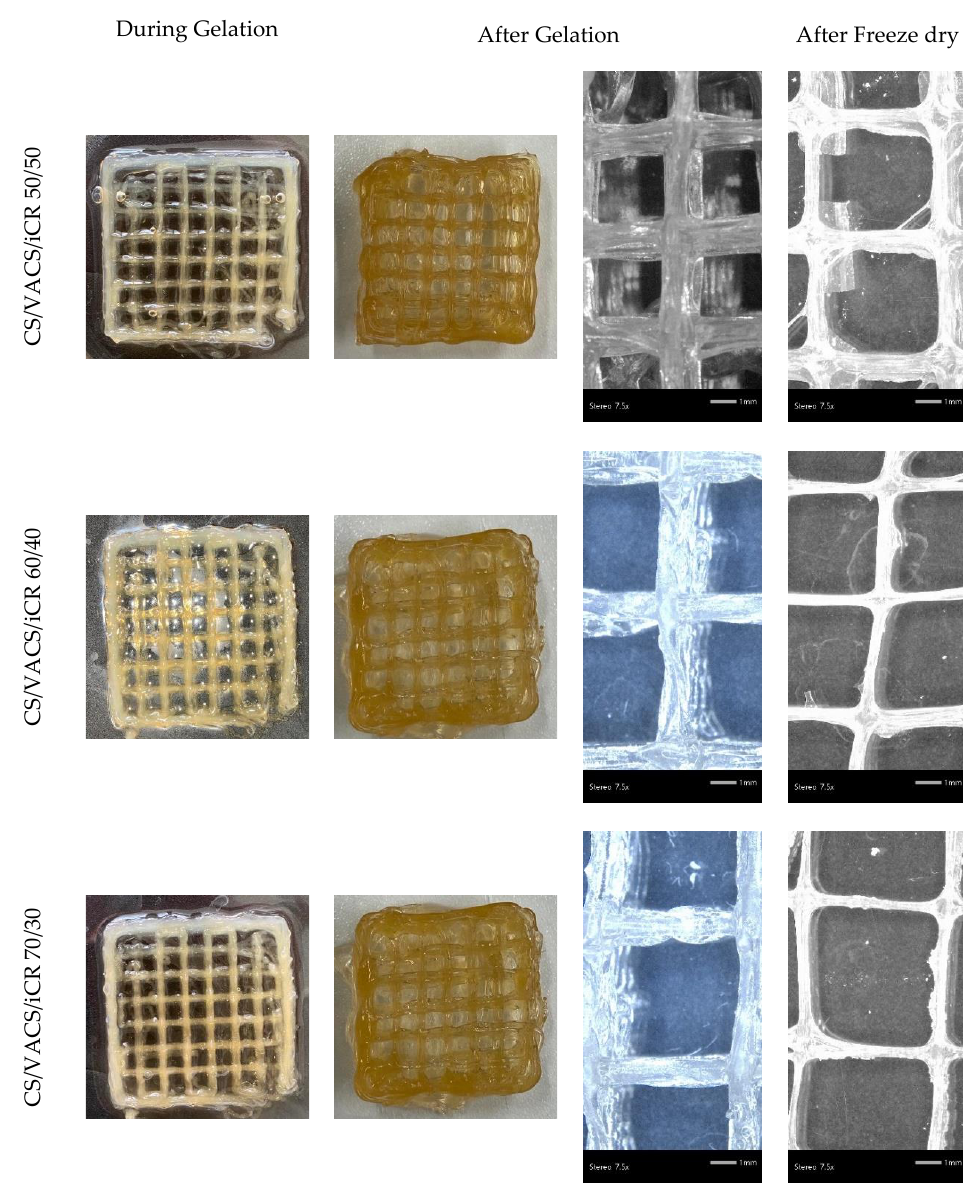
Figure 3. Images of the samples CS/VACS/iCR 50/50, 60/40, and 70/30 before and after gelation and stereomicroscope images of the samples after gelation and after freeze-drying.